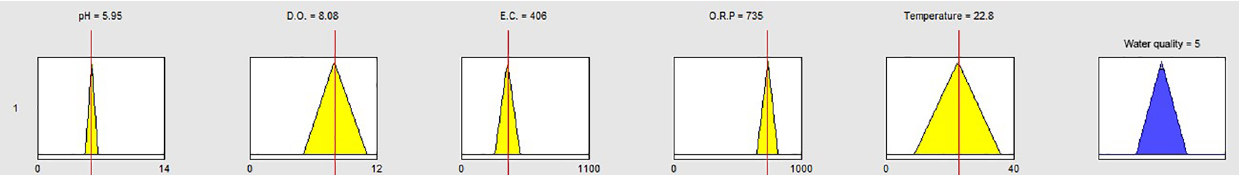
Figure 3. Graphical representation of fuzzy